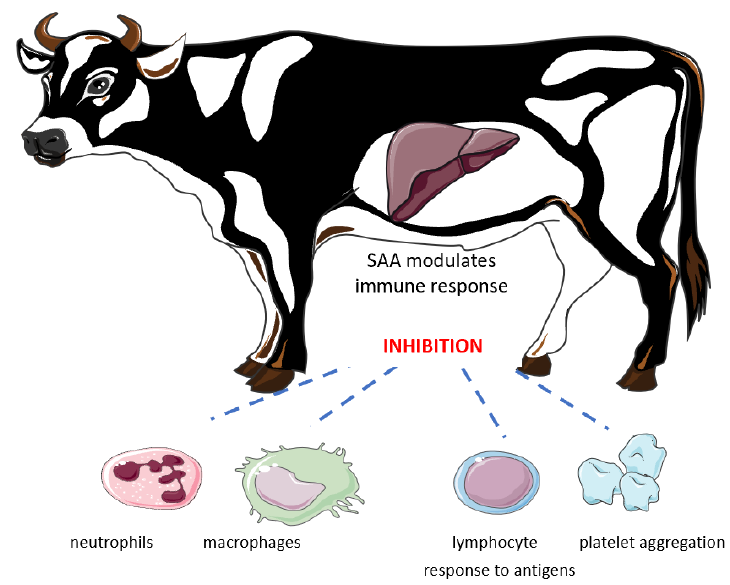
Figure 1. Systemic inflammation stimulates SAA production in cattle.